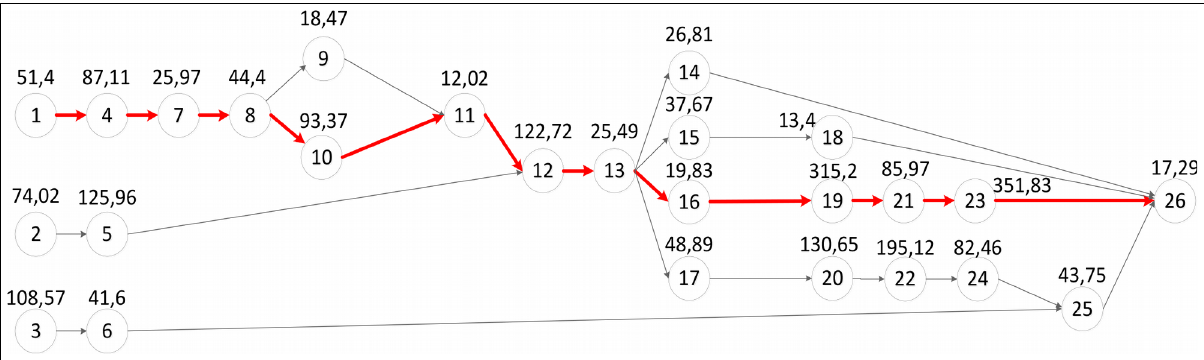
Figure 7. Critical Path